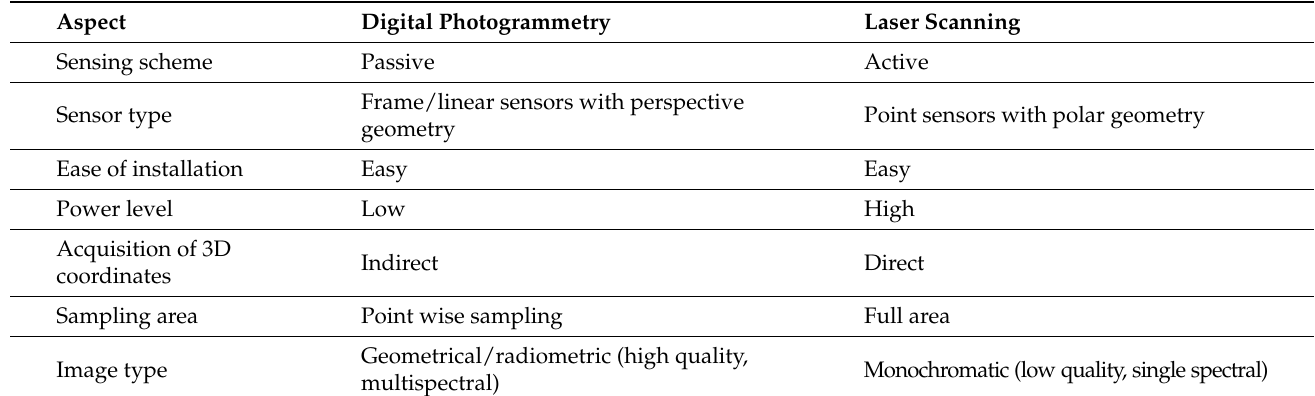
Table 13. Comparison between laser scanning and